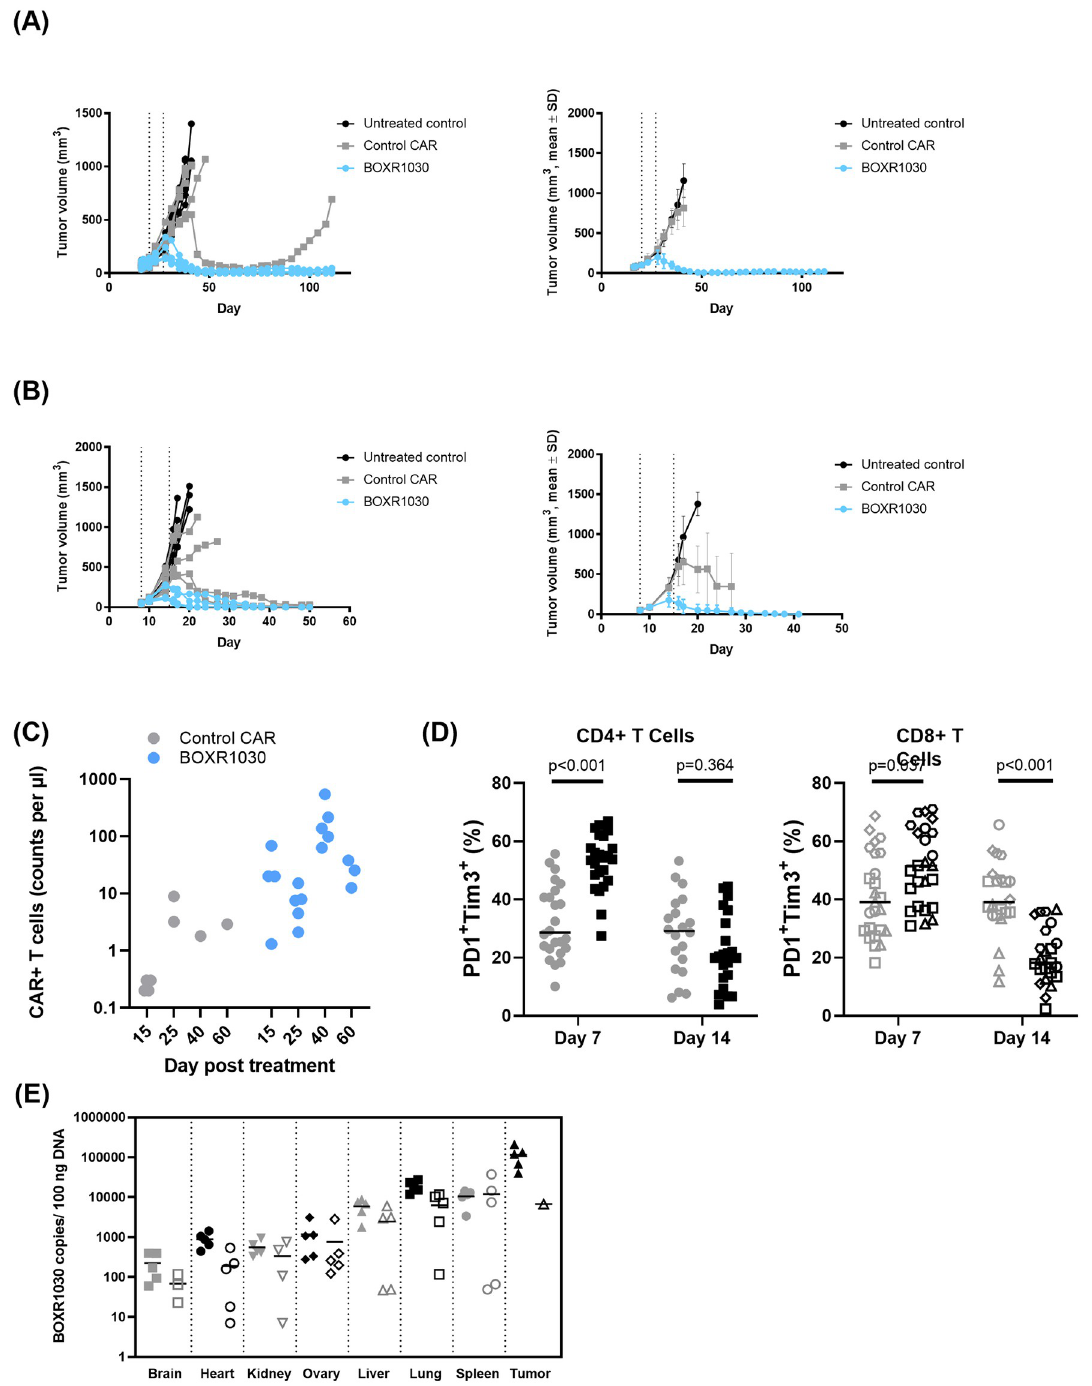
Fig 6. In vivo anti-tumor activity of BOXR1030 T cells. (A) Plot on the right shows Hep3B tumor-bearing model (mean tumor volume 108.7 ± 34.1mm3) NSG mice were treated with two weekly doses of 1 x 10 6 CAR+ control or BOXR1030 T cells each (total dose of 2 x 10 6 CAR+ cells) (dosing days indicated by arrows) and tumor volumes were measured over the course of 110 days. Plot on the left shows data for individual mice and plot on the right shows mean data. Mean tumor volume plots are discontinued when less than 50% of group is remaining. (B) Plot on the right shows JHH7 tumor-bearing mice (mean tumor volume 49.8 ± 7.2mm3) were treated with two weekly doses of 5 x 10 6 CAR+ control or BOXR1030 T cells each (total dose of 10 x 10 6 CAR+ cells) (dosing days indicated by arrows) and tumor volumes were measured out to 50 days. Plot on the left shows data for individual mice and plot on the right shows mean data. Mean tumor volume plots are discontinued when less than 50% of group is remaining. (C) CAR+ T cells were measured